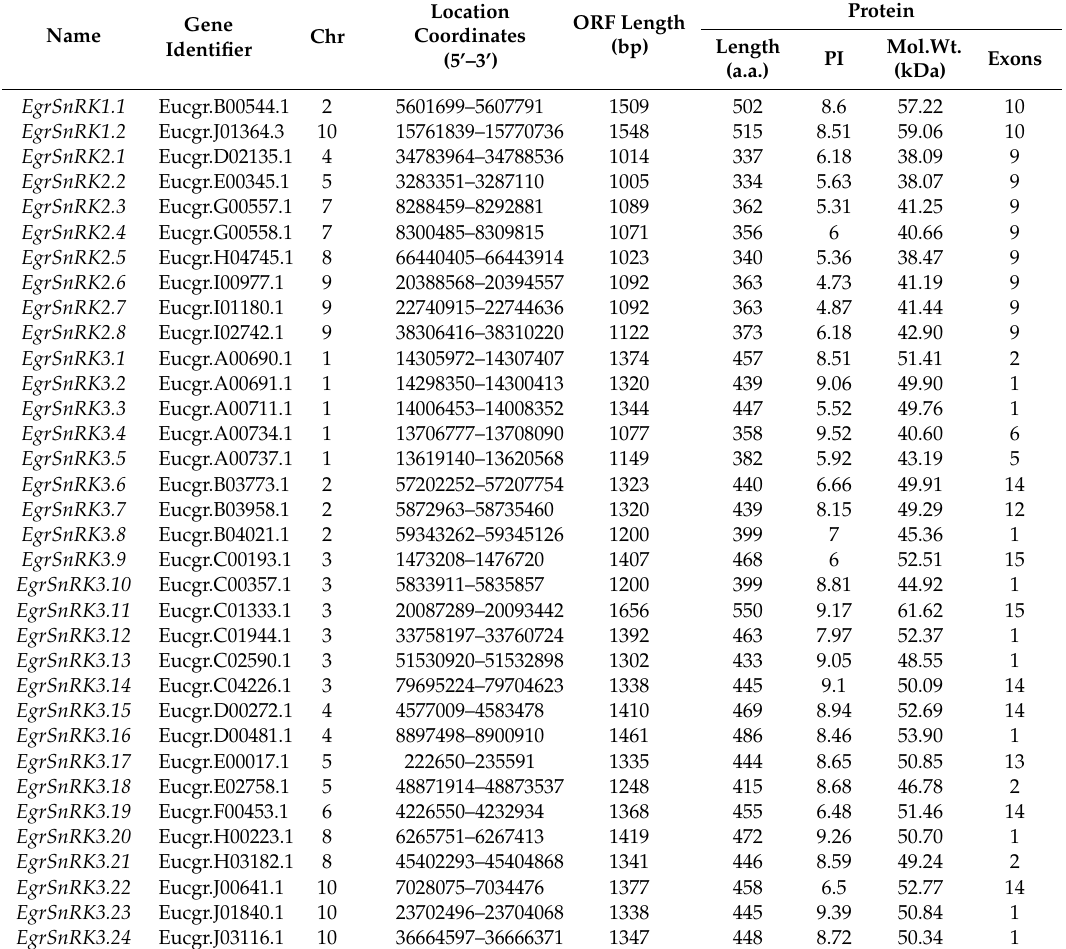
Table 1. List of SnRK genes that are identified in Eucalyptus grandis